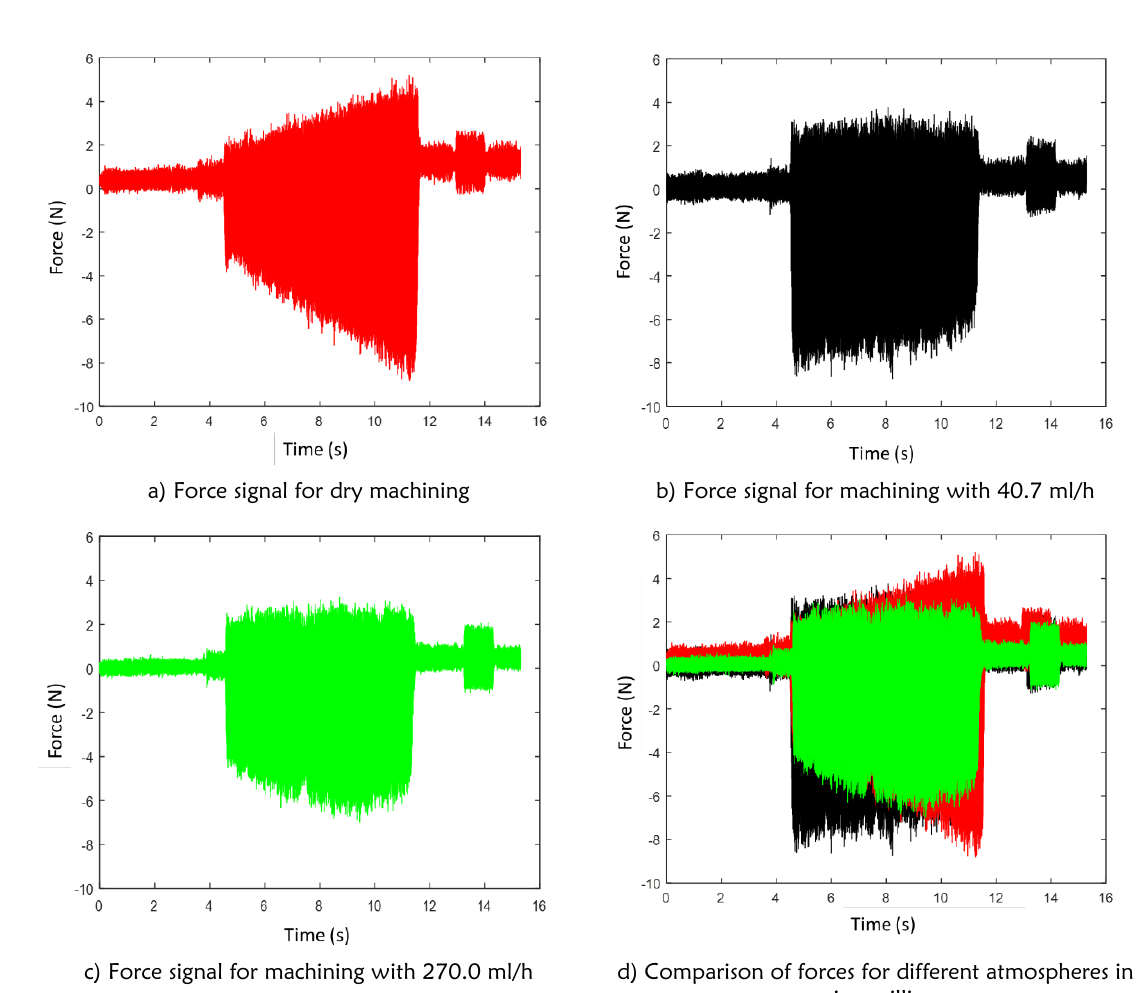
Figure 4: Force signals for different cooling-lubrication conditions